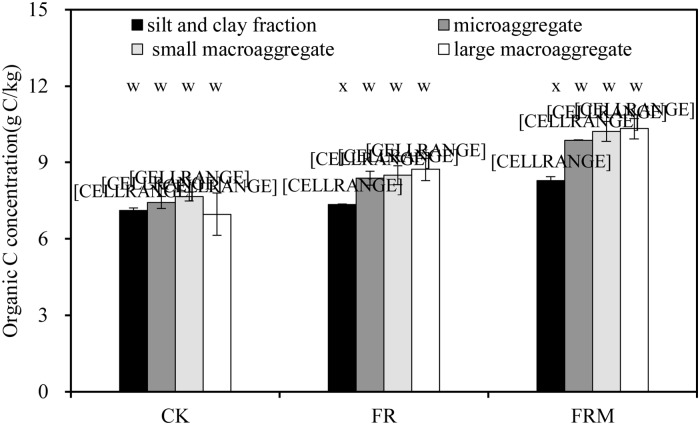
Soil aggregate-associated organic C in the 0- to 20-cm bulk soil affected by compost and inorganic fertilizer.Vertical bars denote the standard error of the mean (n = 3). Different letters a, b and c indicate significant differences between treatments for the same aggregate at P < 0.05. Different letters w and x denote significant differences between aggregates for the same treatment at P < 0.05.